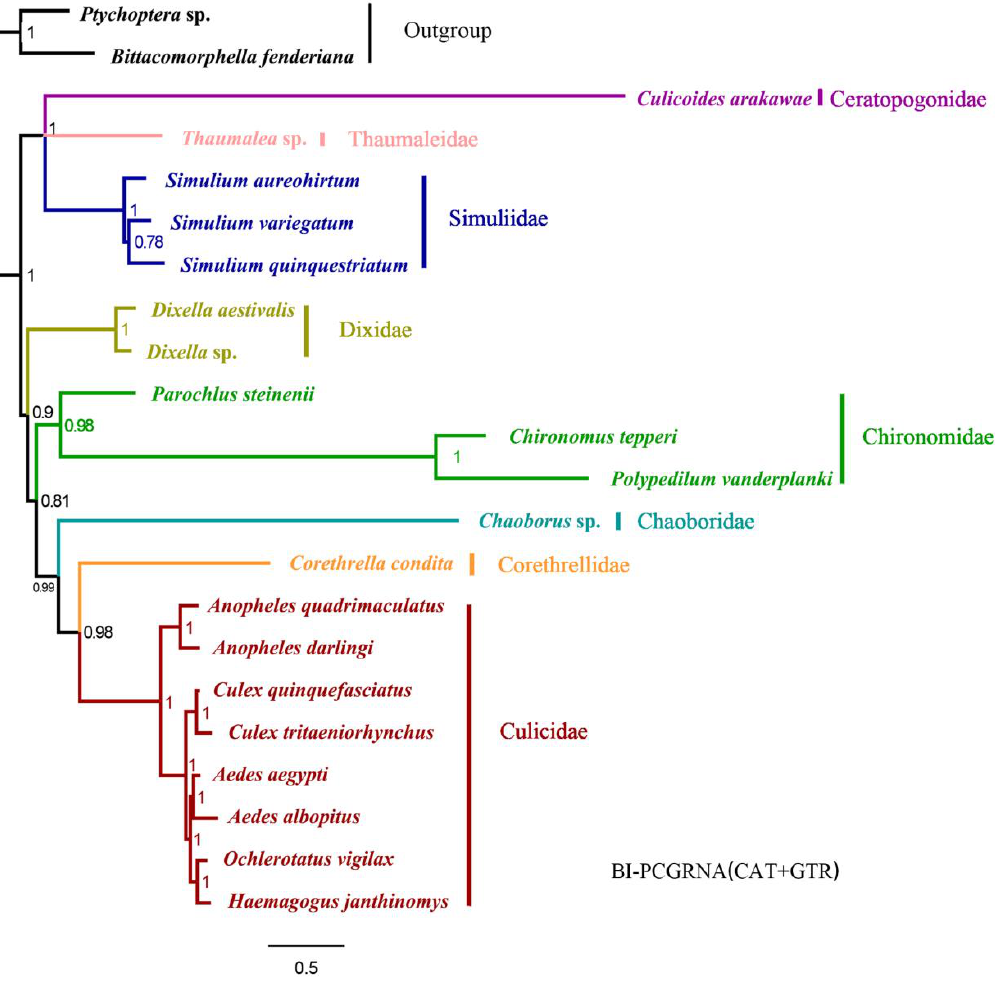
Figure 5. Phylogenetic tree of Culicomorpha based on PCGRNA with heterogeneous models. Phylogram of relationships resulting from BI with Bittacomorphella fenderiana and Ptychopter sp. as outgroups. Numbers above the branches are posterior probabilities.